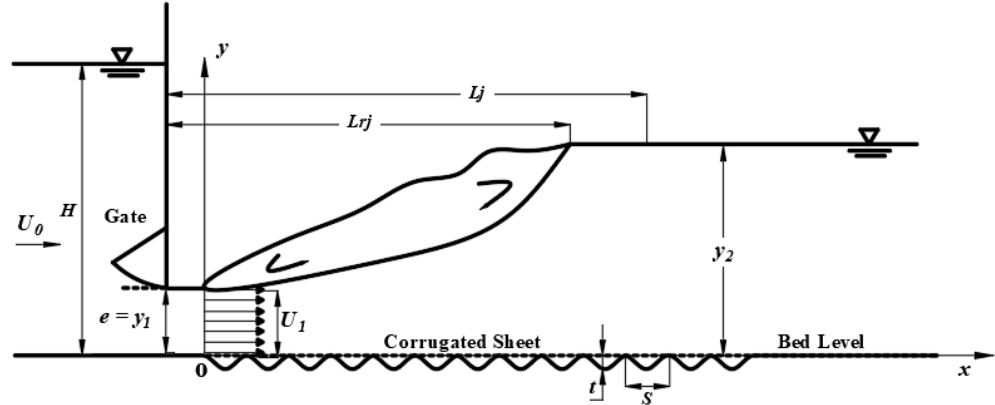
Figure 1. Schematic view and dimensions of the benchmark example (modified from Figure 1 in Ead and Rajaratnam [1]).